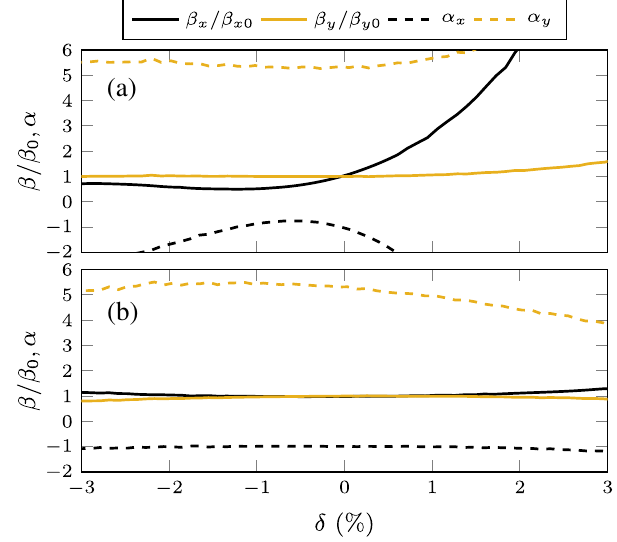
FIG. 6. Plot of the tracked slice Twiss functions as functions of δ at the end of (a) original BC2 (see Fig. 3), (b) the CSR- mitigating modification of the third-order compressor (see Fig.